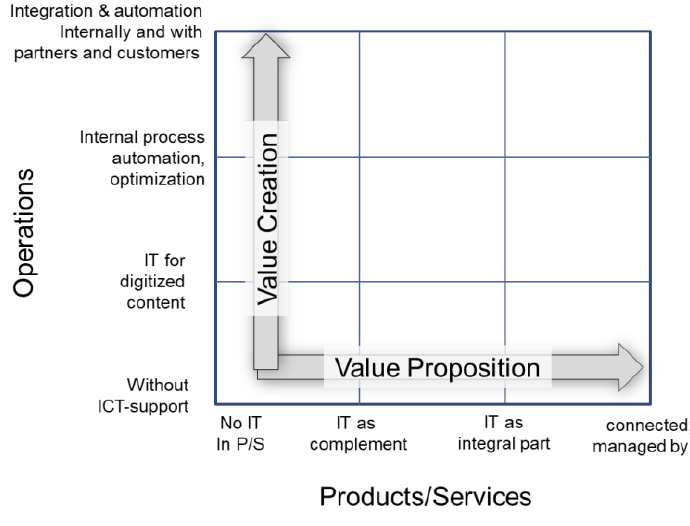
Figure 1. Dimensions of digital transformation and their